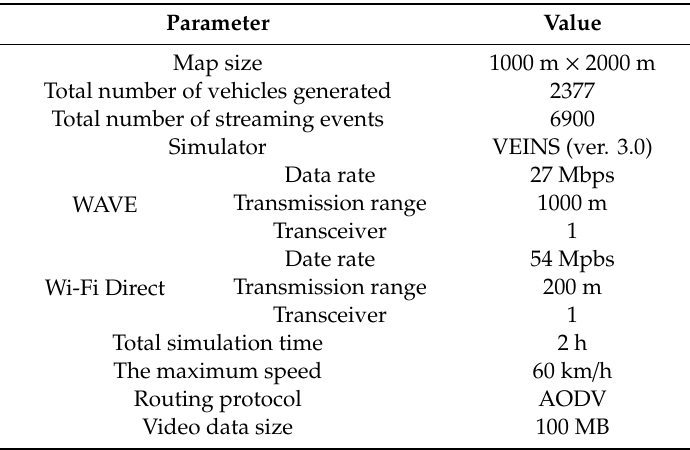
Table 2. Simulation parameters.